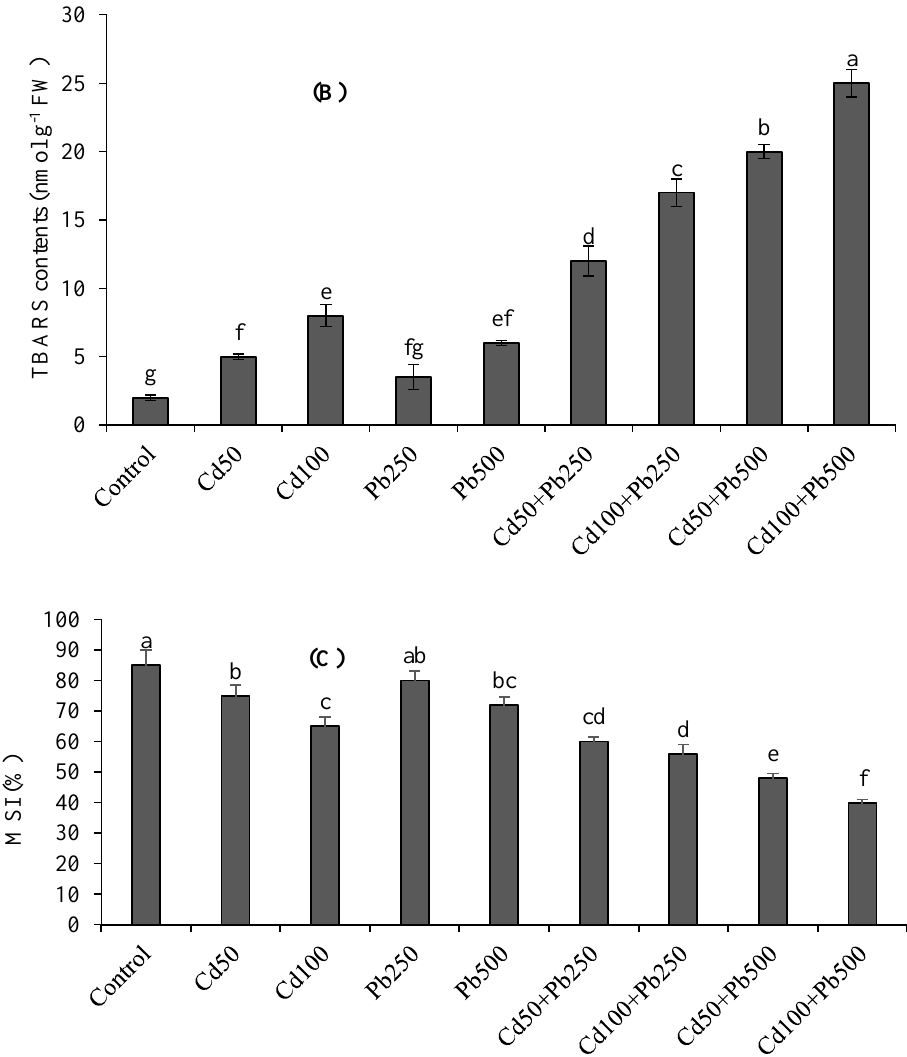
Figure 1. Effects of different levels of Cd, Pb and their combinations on H 2 O 2 contents ( A ), TBARS contents ( B ) and MSI ( C ) of quinoa. Different letters represent the significant difference among the treatments at a 5% significance level.